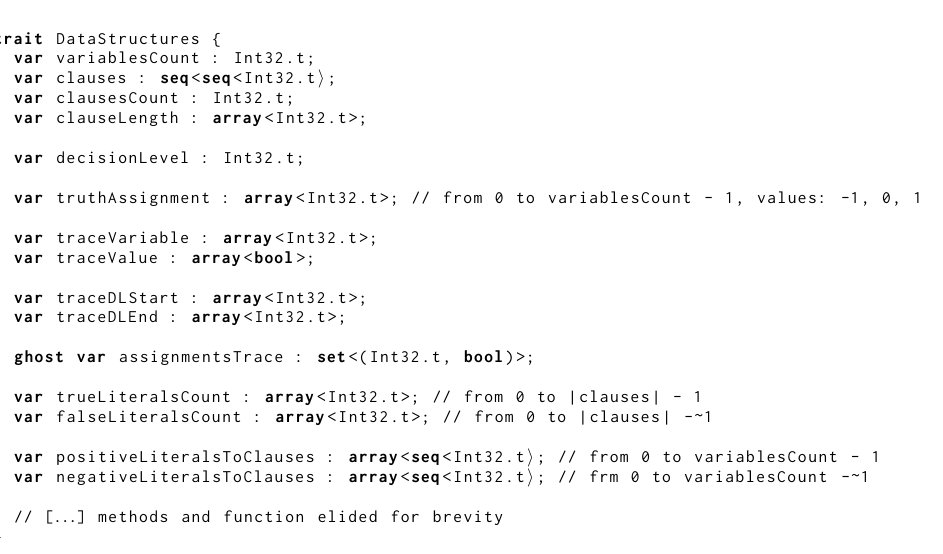
Figure 3. The fields (file solver/data_structures.dfy ) we use for storing the formula and the solver state. The fields are presented in a slightly different order to improve